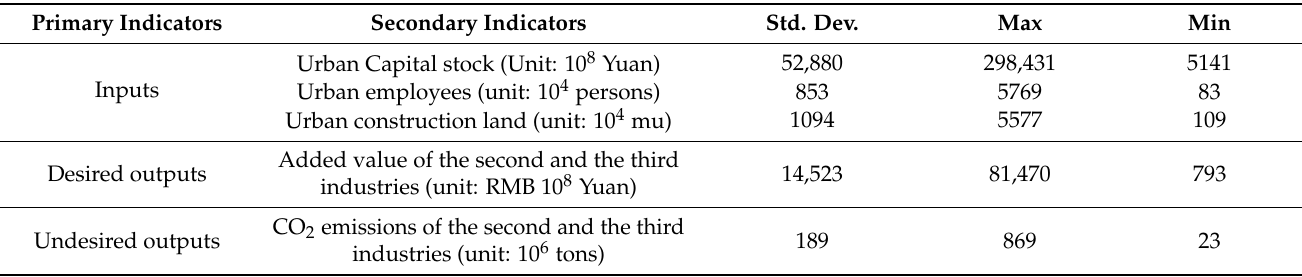
Table 1. ULGUE evaluation indicator